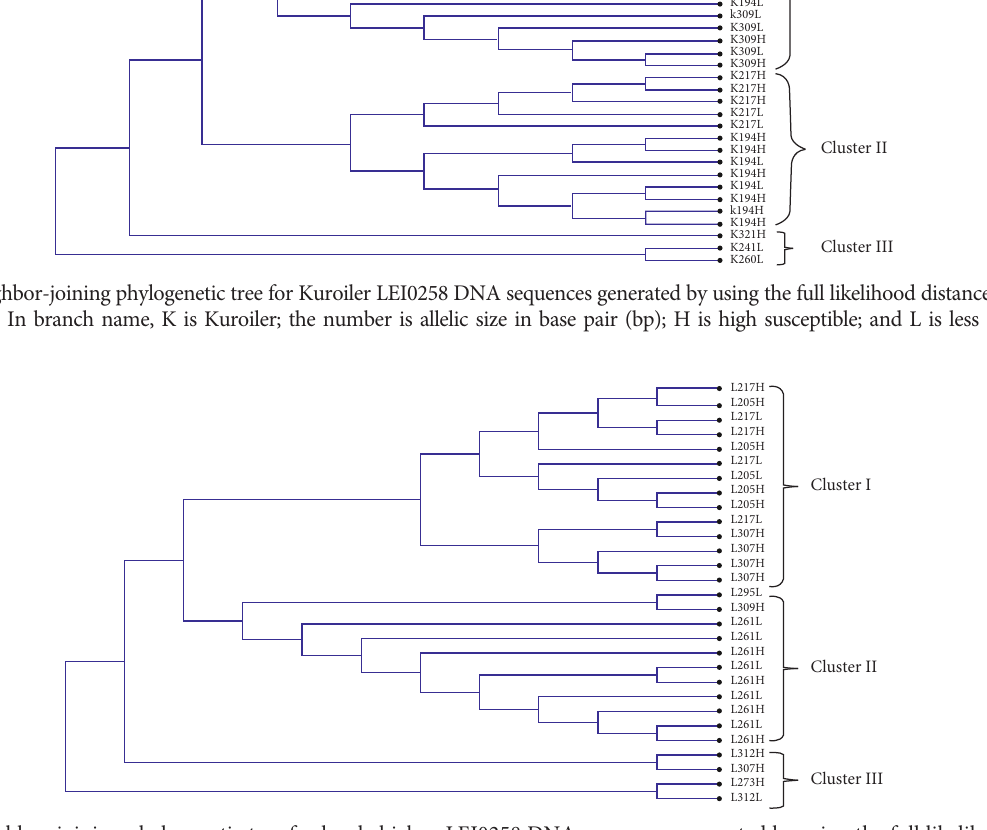
Figure 2: A neighbor-joining phylogenetic tree for local chicken LEI0258 DNA sequences generated by using the full likelihood distance and general reversible model. In branch name, the first L is local chicken; the number is allelic size in base pair (bp); H is high susceptible; and the last L is less